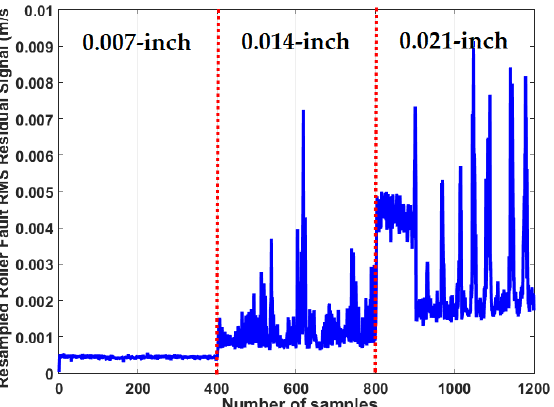
Figure 13. The RMS resampled roller fault residual signal using the proposed ADT algorithm for crack size identification.